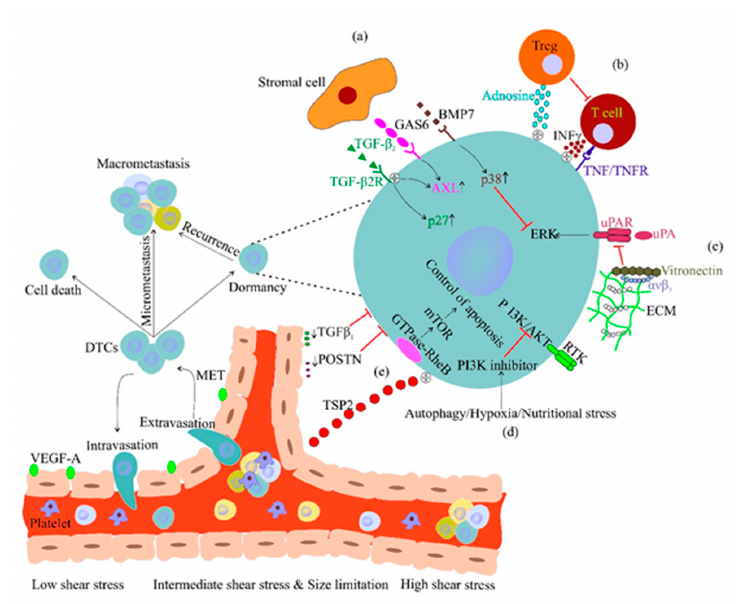
Figure 2. Cancer cell dormancy. Low shear stress and size limitation at vascular branches promote CTC extravasation. Disseminated tumor cells (DTC) dormancy is supported through different mechanisms: ( a ) Growth arrest-specific protein 6 (GAS6) activates AXL -associated dormancy signaling. Transforming growth factor- β 2 (TGF β 2) and BMP7 signaling mediate the production of cell cycle inhibitors by dormant cells. ( b ) Regulatory T (Treg) cells-derived adenosine and tumor necrosis factor receptor 1 (TNFR1) signaling protect tumor cells against oxidative stress and induce dormancy signals, respectively. ( c ) The ECM integrin α v β 3 binds to urokinase plasminogen activator (uPA), and suppresses the dormancy effect of Extracellular signal-Regulated Kinase (ERK) signaling. ( d ) Stressful conditions result in PI3K-AKT survival pathway inhibition. ( e ) The GTPase RHEB-mTOR pathway suppresses apoptosis in DTCs. Endothelial cells produce thrombospondin 2 (TSP2) that maintains DTCs in a dormant state; however, TGF β 1 and periostin (POSTN) promote DTC proliferation.